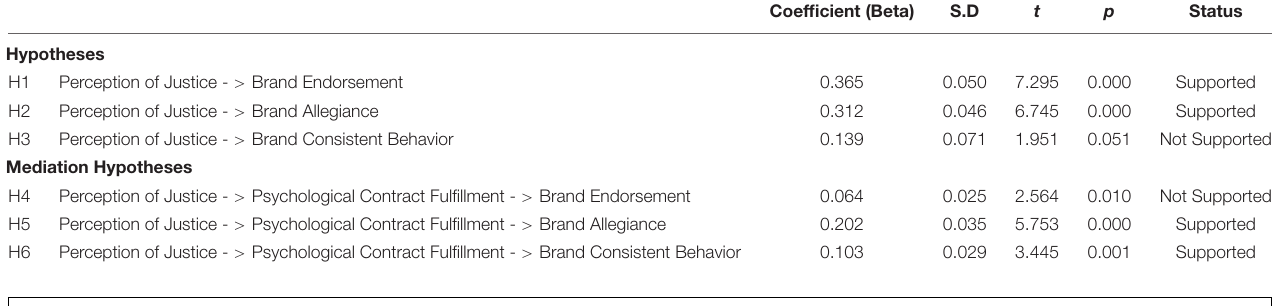
TABLE 8 | Hypotheses testing.